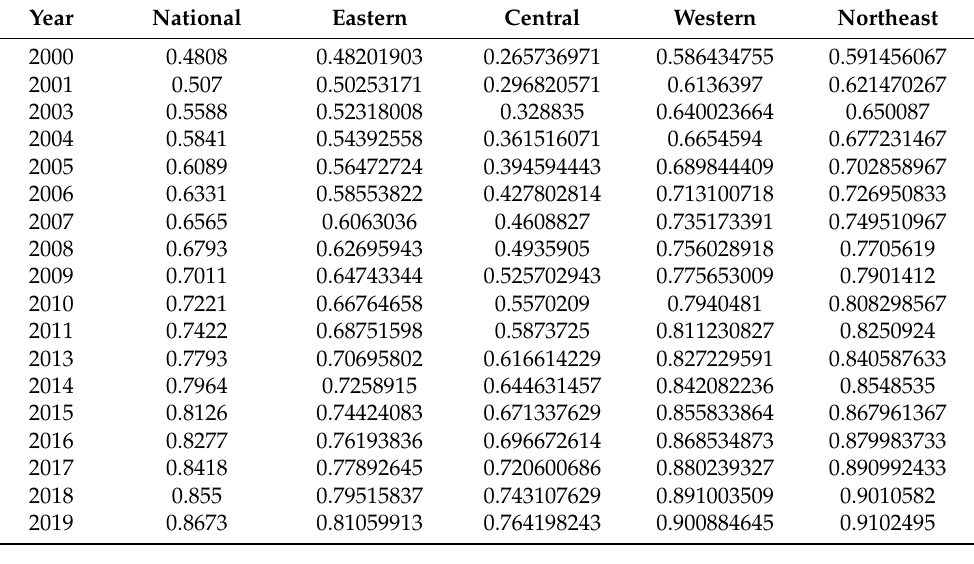
Table 4. National and regional green production efficiency of grain from 2000 to 2019.